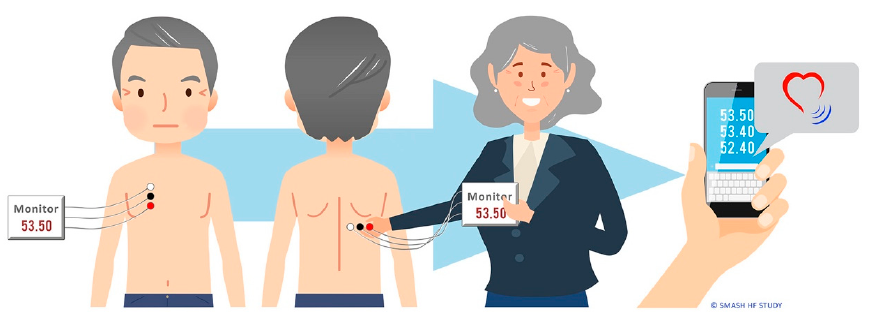
Figure 1. Illustration of how informal caregivers daily placed the cables for measurements of non- invasive lung impedance to support the person with heart failure for 30 days at home. The impedance measurements were transmitted by SMS to the study’s personnel in each